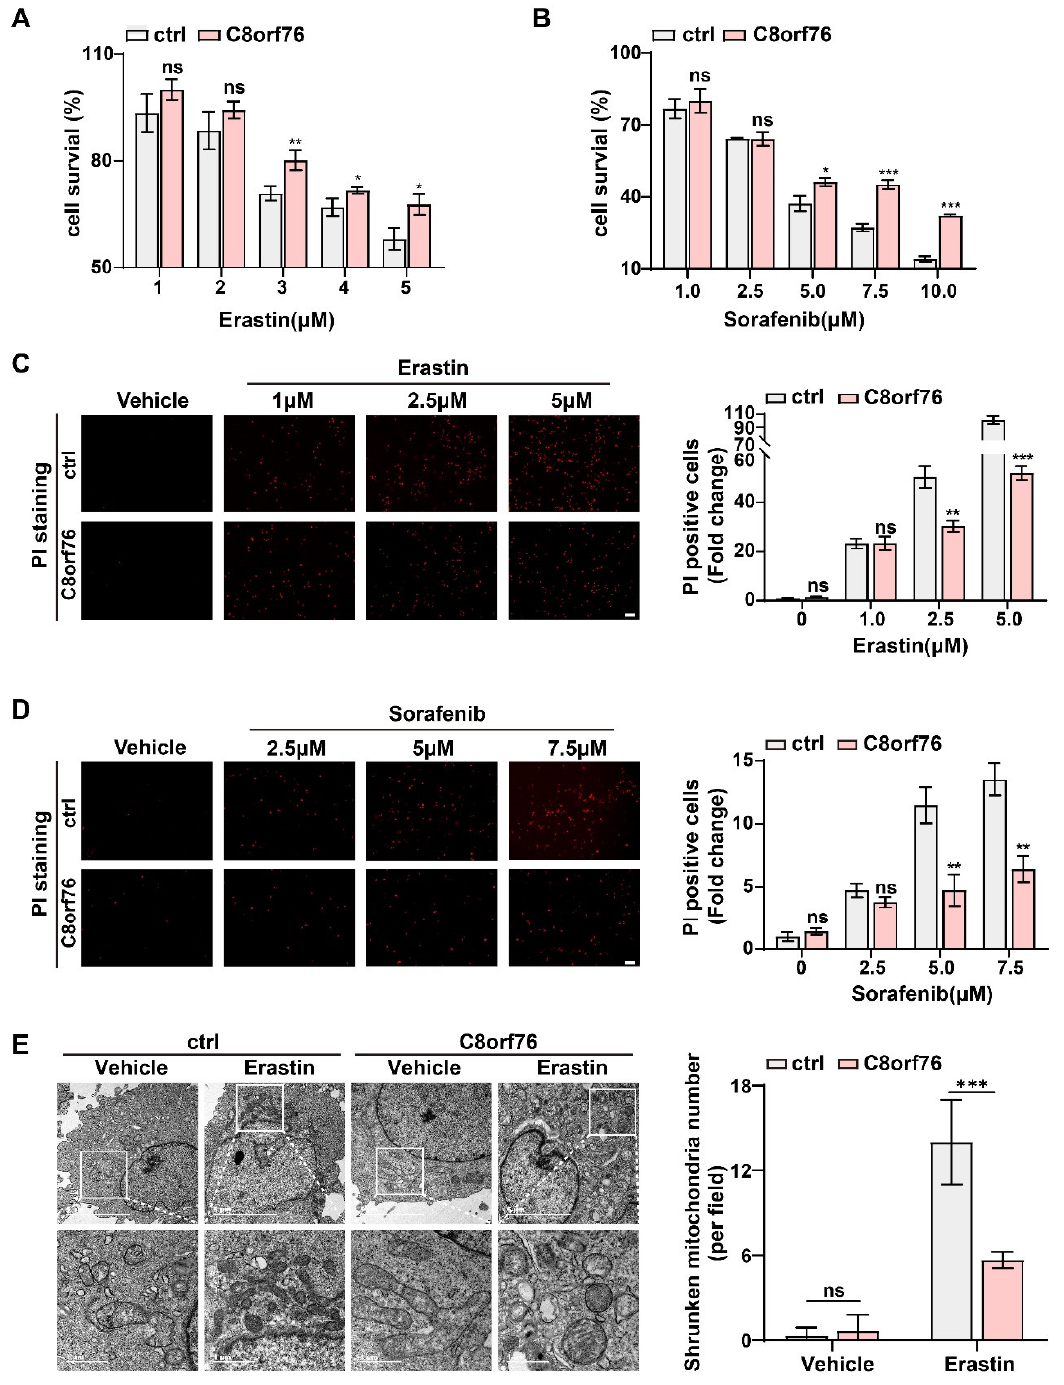
Figure 5. C8orf76 overexpression mediated tumor resistance towards erastin and sorafenib. ( A , B ) Erastin or sorafenib treatment resulted in a dose-dependent inhibition of cell viability. Cell survival was measured by MTS. ( C , D ) PI staining showed the number of dead cells following the treatment of erastin at the concentration of 1 μM, 2.5 μM, and 5 μM or sorafenib at the concentration of 2.5 μM, 5 μM, and 7.5 μM for 24 h. Scale bars represent 100 μm. ( E ) C8orf76-overexpressed SK-Hep-1 cells were treated with erastin and analyzed by transmission electron microscopy. Data were presented as mean +SD. * p < 0.05; ** p < 0.01; *** p < 0.001; ns, not significant.